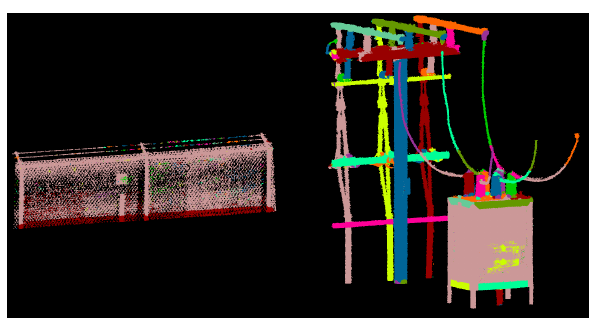
Figure 10. Segmentation results